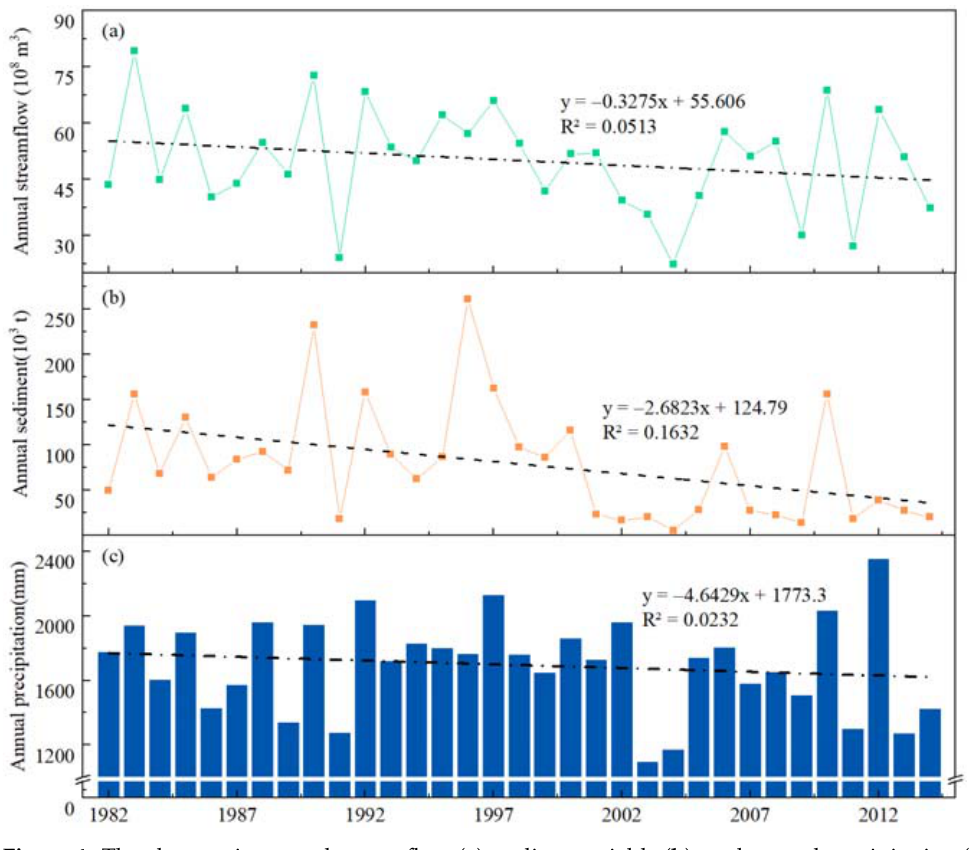
Figure 4. The changes in annual streamflow ( a ), sediment yields ( b ), and annual precipitation ( c ) in MW.